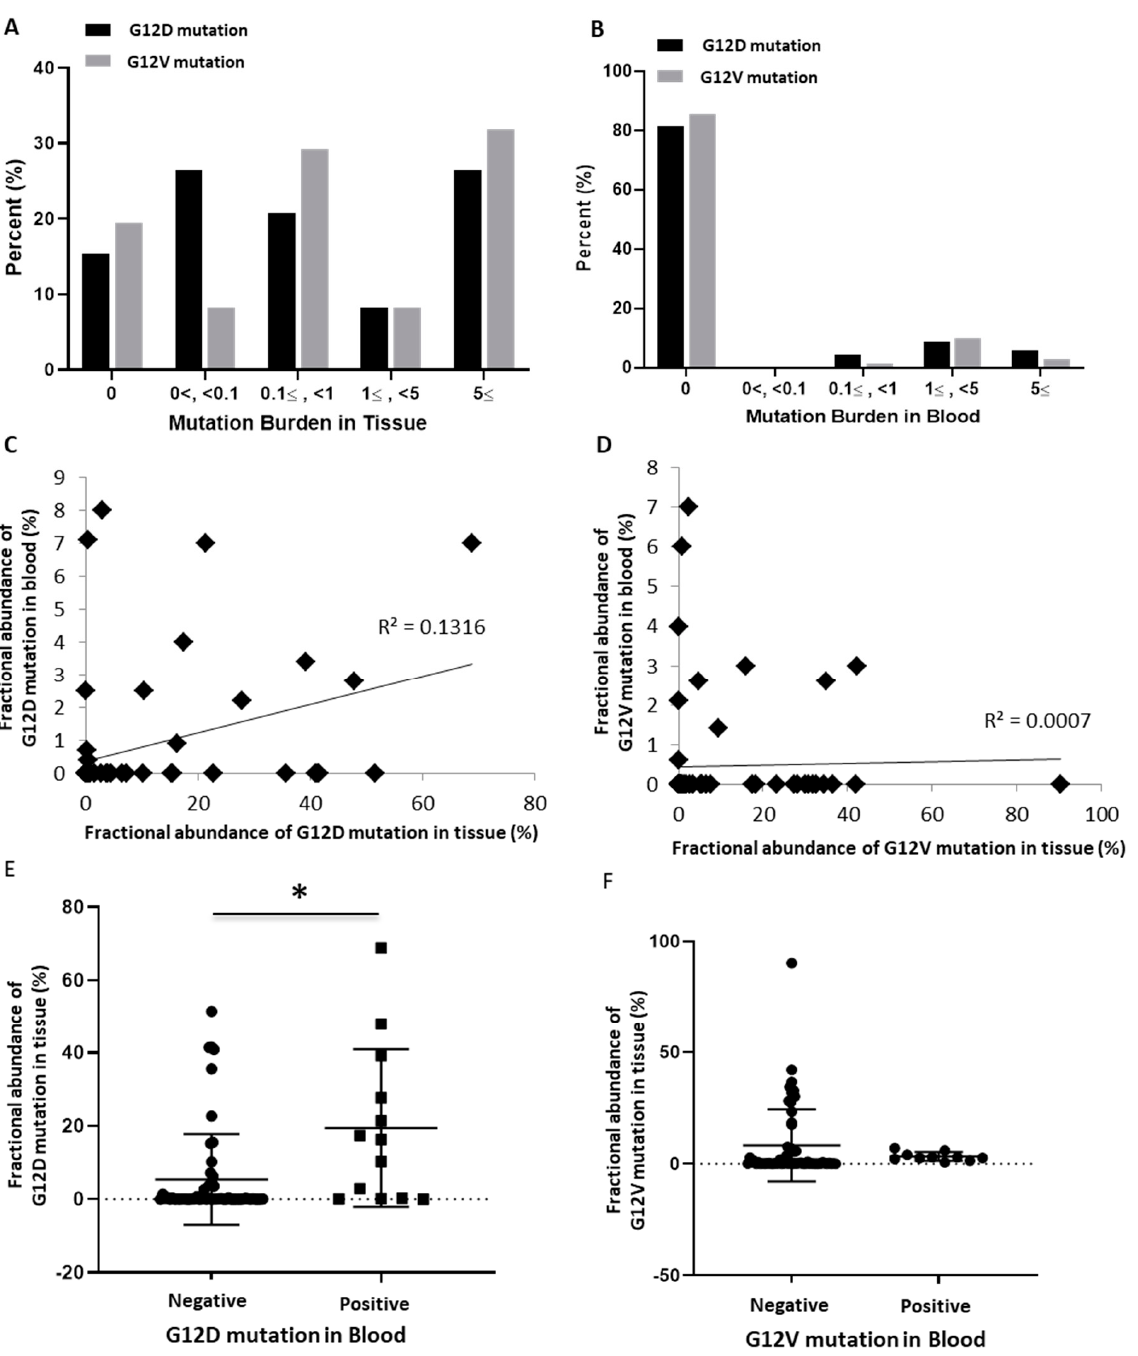
Figure 2. The abundance of KRAS G12D/G12V mutations in tissues and blood ( n = 70) . ( A ) Comparison between G12D and G12V mutations according to the degree of fractional abundance in tissues. ( B ) Comparison between G12D and G12V mutations according to the degree of fractional abundance in blood. ( C ) Correlation of the G12D mutation burden in tissues and blood (R 2 = 0.1316). ( D ) Correlation of the G12V mutation burden in tissues and blood (R 2 = 0.0007). ( E ) Mutation burden of tissues according to the presence or absence of the G12D mutation in blood (*; p = 0.0024). ( F ) Mutation burden of tissues according to the presence or absence of the G12V mutation in blood ( p = 0.3386).